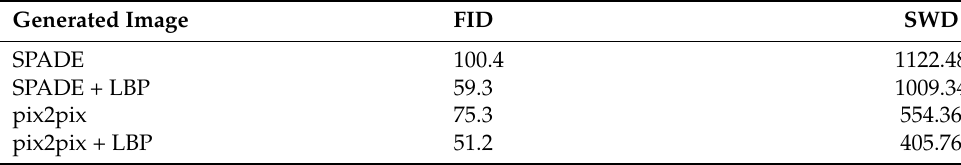
Table A1. FID according to the GAN models. (Resolution: 128 ×